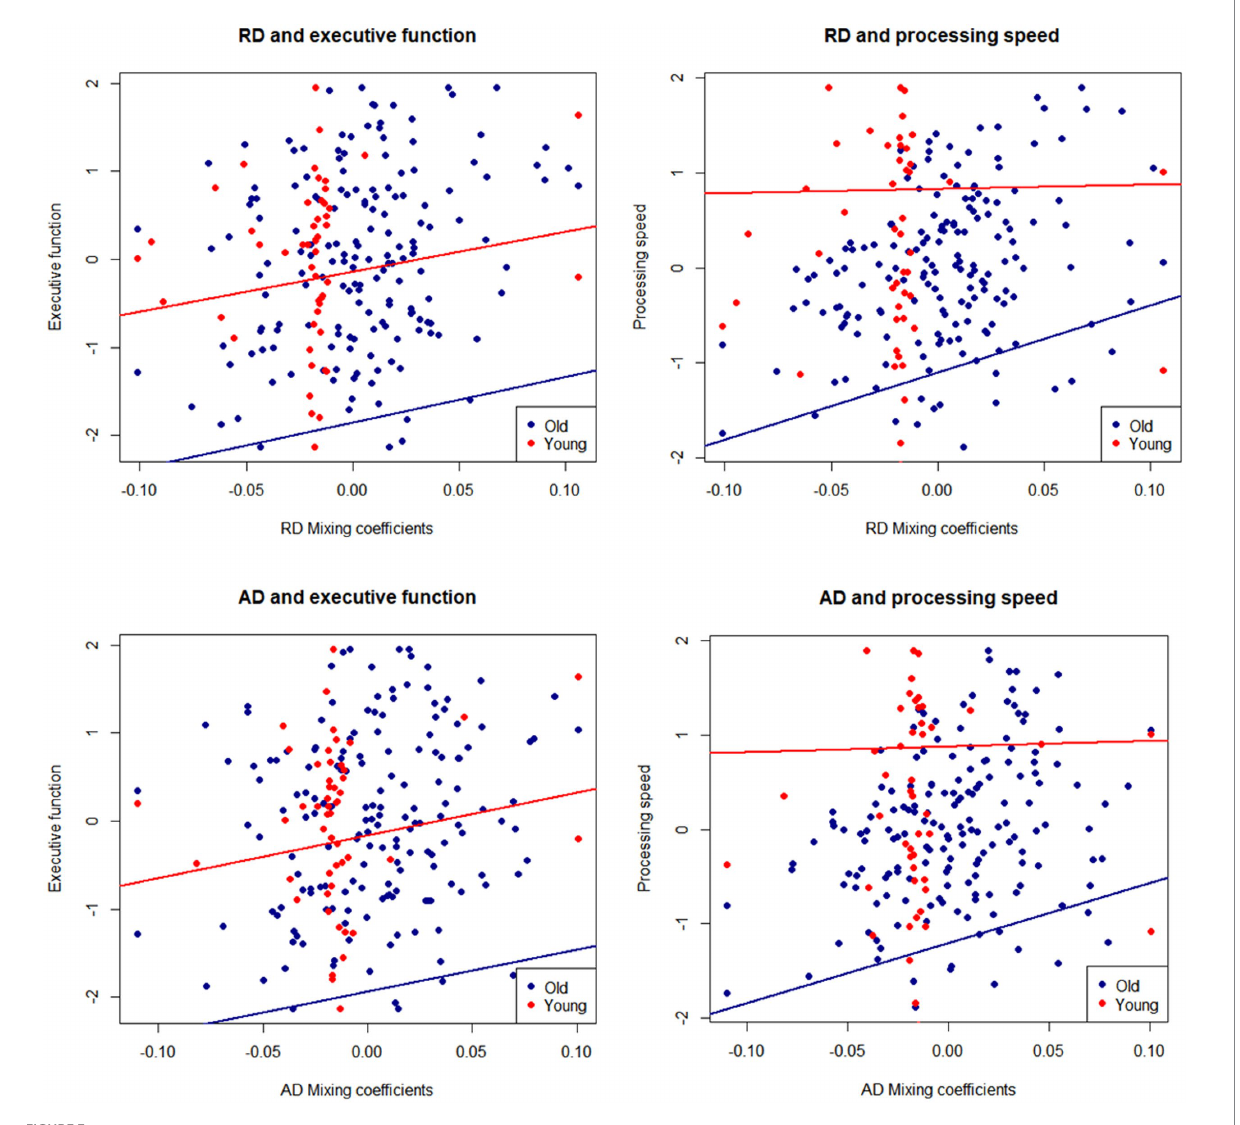
FIGURE 3 Mixing coefficients for IC2-RD and IC2-AD and association with executive function and speed composites. Lines of fit are adjusted by sex and education. Cognitive scores are residualized for age.